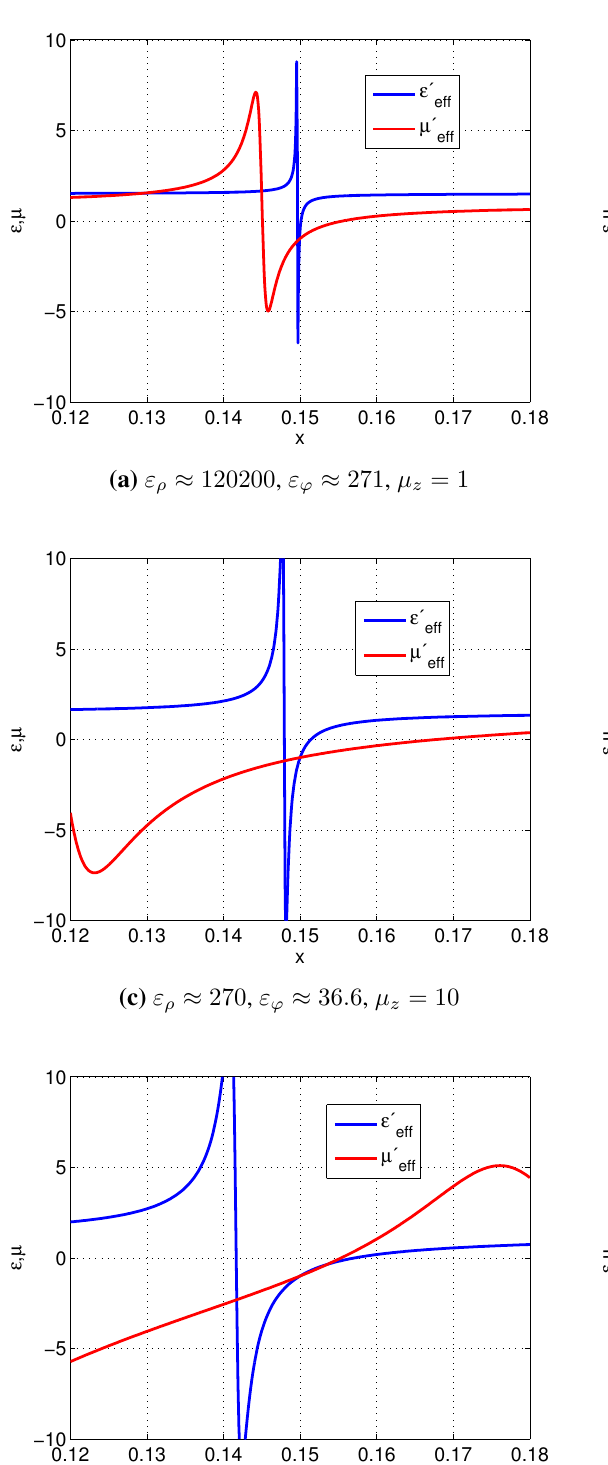
and ε (cid:48) of a lattice of magnetodielectric RA cylinders eff eff = µ (cid:48) = 1 at x = 0 . 15 eff eff −